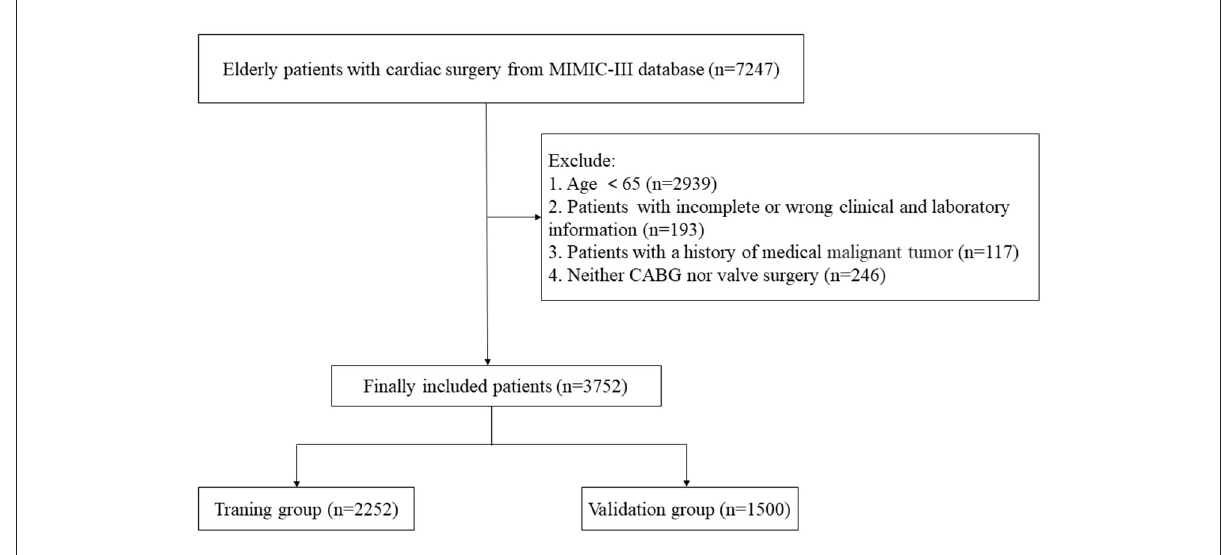
FIGURE1 The flowchart of patient